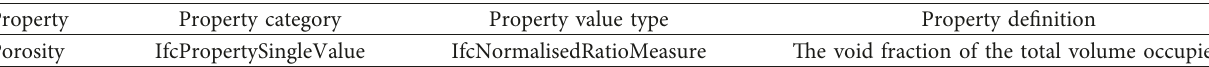
Figure 4: Three types of IFC extensions. Table 3: The IFC expression of volume ratio of raw materials.